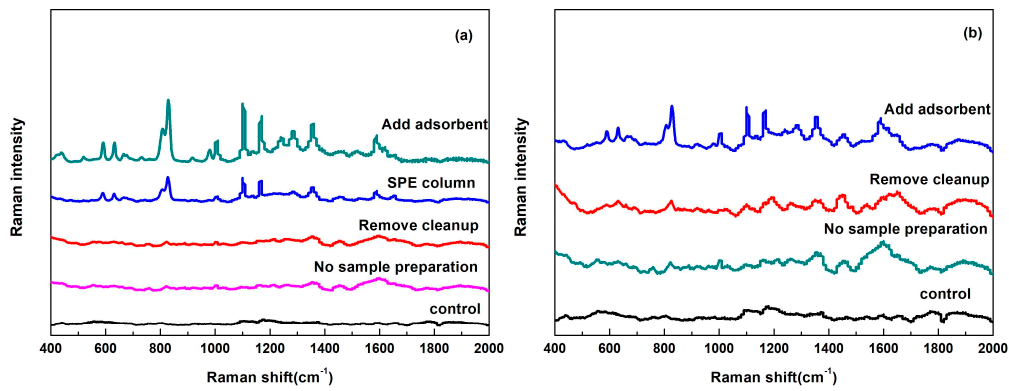
Figure 6. SERS spectra of flusilazole extracts in pears with different sample preparation processes ( a ) 1 µ g/g and ( b ) 0.2 µ g/g.